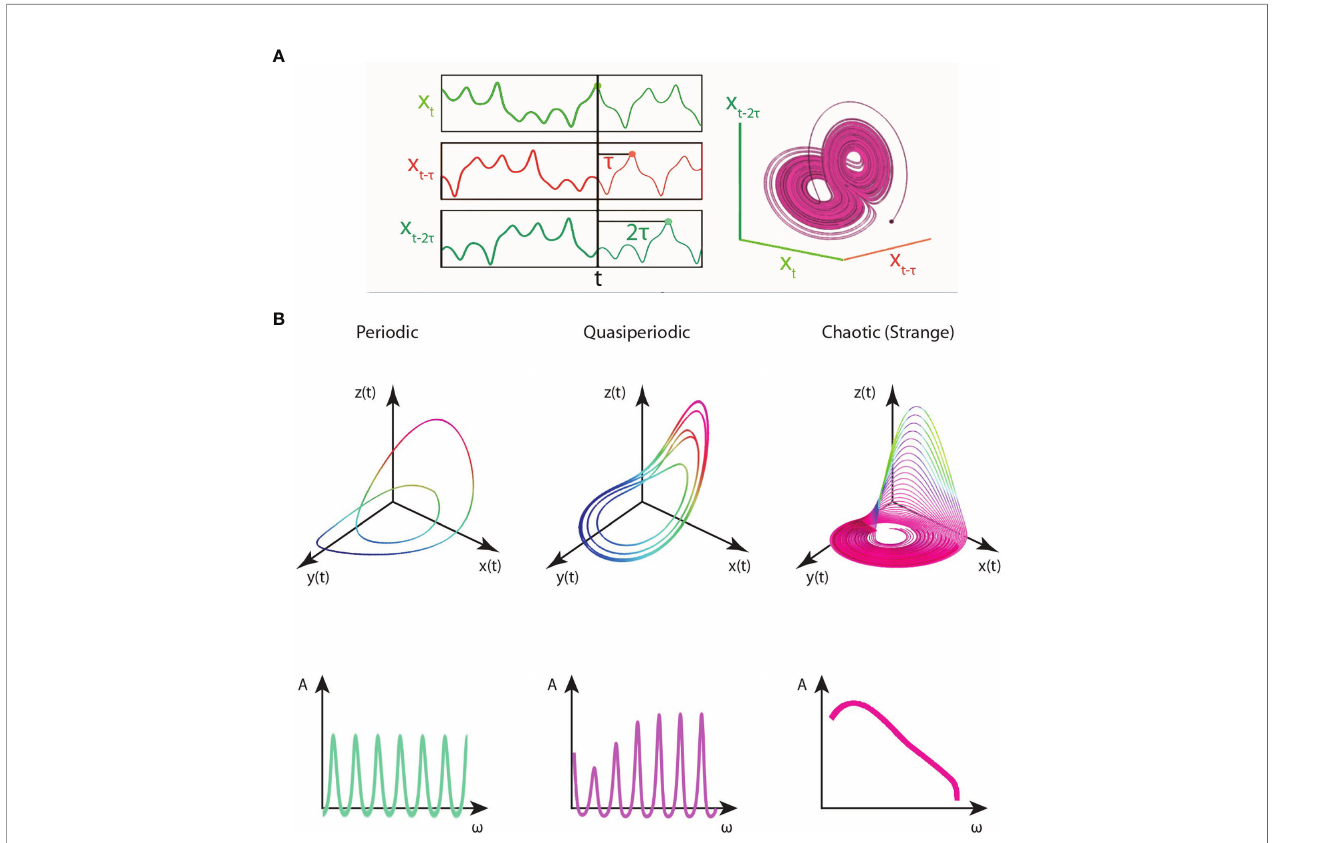
FIGURE 2 | Attractors and oscillations. (A) Time-delay Coordinate Embedding. A schematic of attractor reconstruction from a time-series signal of some variable X(t) is shown by time-delay embedding (i.e., Convergent Cross Mapping). t represent the time-delay. However, for complex large-scale datasets, machine learning algorithms such as reservoir computing (RC) and deep learning architectures are suggested (Image was adapted from 37). (B) Three different types of attractors which can self-organize in the signaling/expression state-space of cancer processes are shown: a limit cycle (periodic oscillation), quasi-periodic attractor, and a strange attractor (chaotic). The simplest of attractors, a fi xed-point, is not shown herein. Their corresponding frequency spectra are shown below, with the oscillator ’ s angular frequency as the independent variable and the amplitude of the oscillations as the dependent variable. The oscillation of a limit cycle attractor has a de fi ned amplitude (A) and peak in the frequency spectrum at a frequency ( w ). A broad frequency spectrum is observed for the strange attractor, which exhibits a fractal-dimension in state-space. However, the frequency/power spectrum can be more complex depending on the system. For instance, complex attractors, such as those observed fl uid turbulence, exhibit a broad frequency spectrum with an anomalous power-law scaling (i.e., multifractality) due to